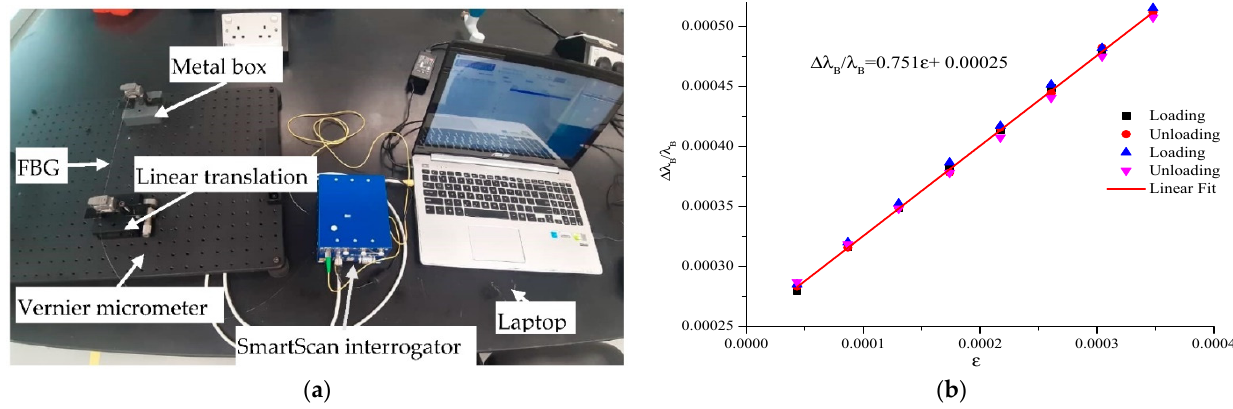
Figure 2. Strain calibration of FBG sensor. ( a ) FBG sensor strain calibration setup. ( b ) FGB strain calibration result.